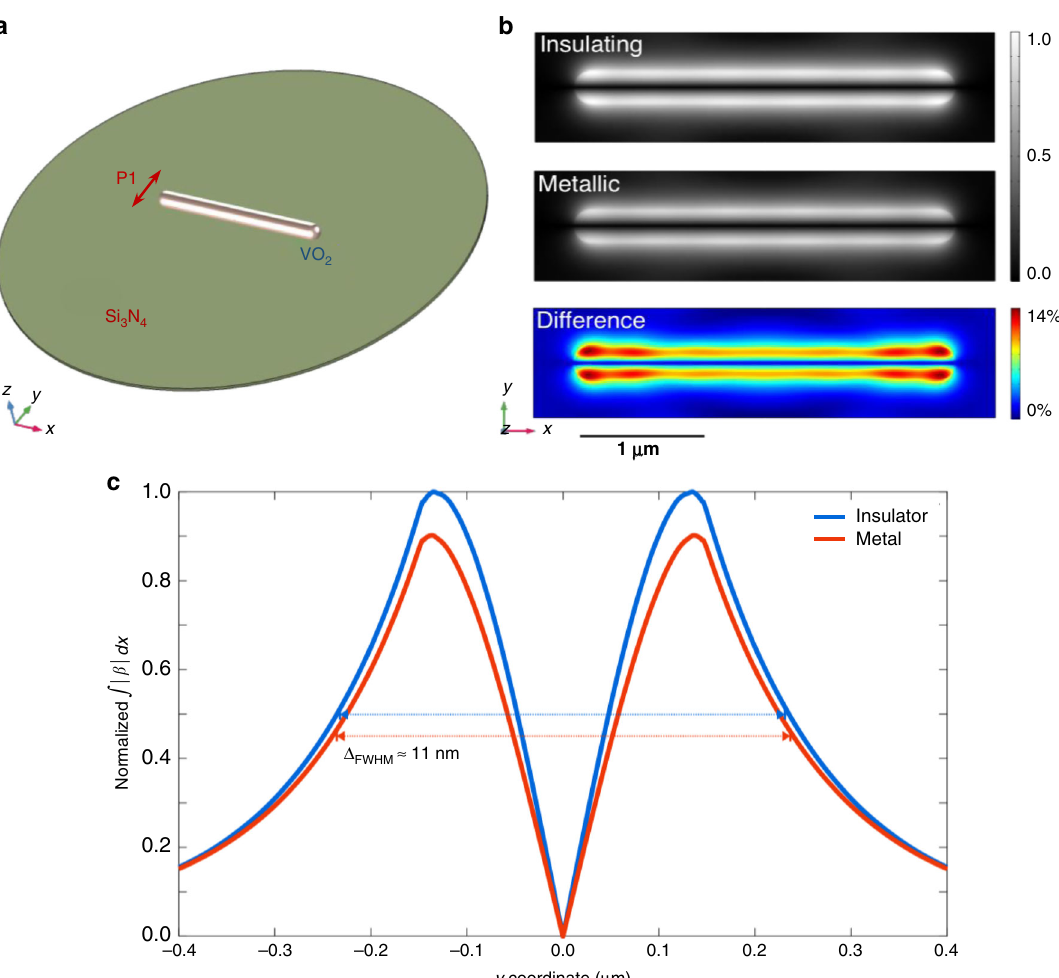
Fig. 3 Numerical simulations of the one-color PINEM experiment. a Simulation geometry of a 3 μ m long VO 2 NW (300 nm diameter) placed on a 50 nm Si 3 N 4 substrate. The red arrow shows the polarization direction of P1 optical pulse. b Simulated results of the interaction strength ∣ β ∣ as obtained from the scattered near- fi eld distribution around the VO 2 NW for an insulating phase (top panel) and a metallic phase (middle panel), together with their difference map (bottom panel). c Simulated interaction strength integrated along the whole NW and plotted as a function of the spatial y -coordinate across the NW for both the insulating (blue line) and metallic (orange line) phases. Both curves are normalized to the peak maximum obtained in the insulating phase. The arrows represent the FWHM for the insulating (blue) and metallic (red) cases. Simulation reveals a difference of about 11 nm between the two widths, in favor of the metallic phase, as observed